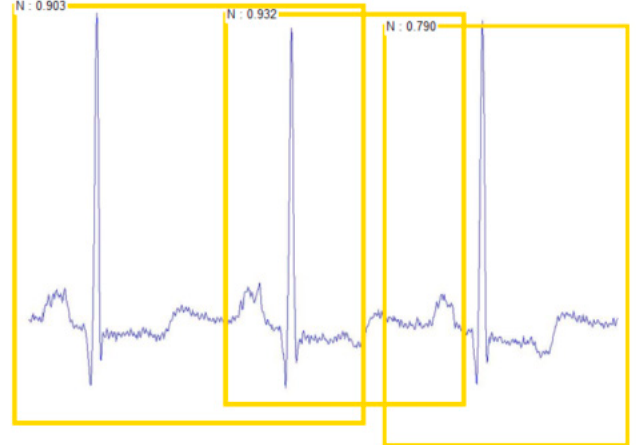
Figure 14. The detected sample graph consisting of multiple ECG beats. Figure 14. T he detected sample graph consisting of multiple ECG beats.